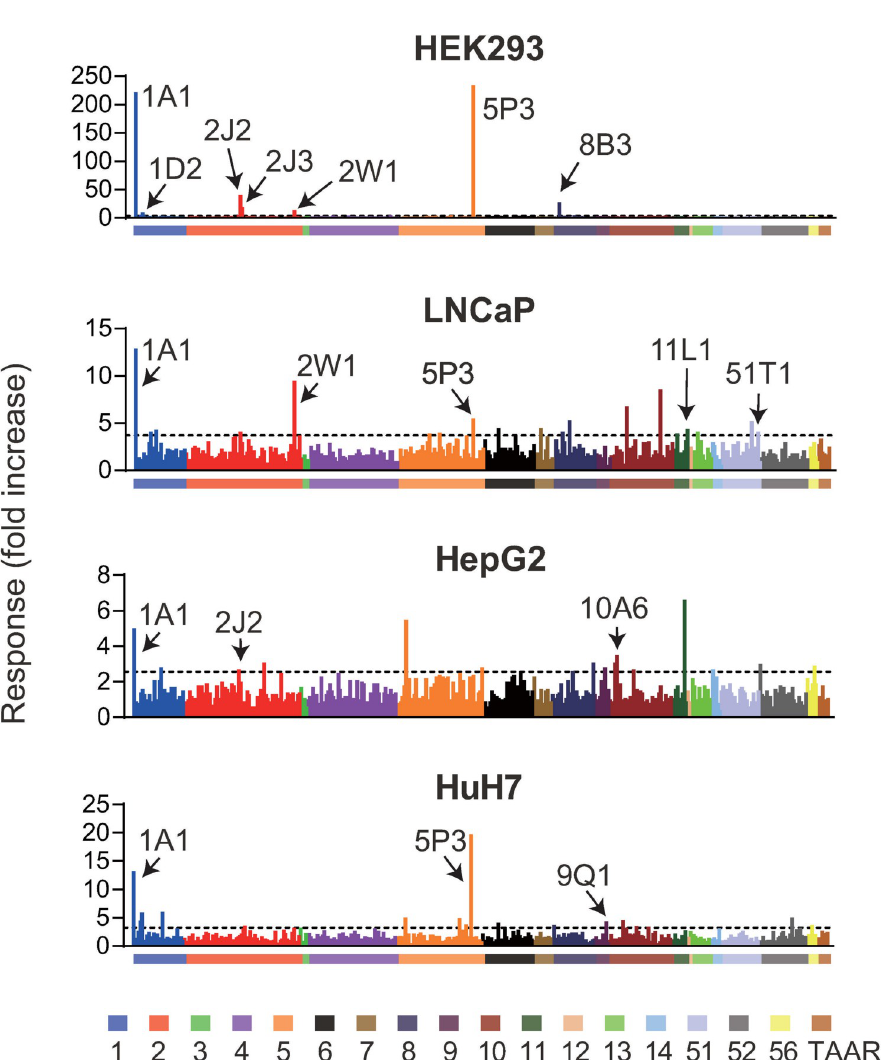
Fig 2. Capacity of three cell lines as a functional expression cell system for ORs. A total of 412 ORs were expressed in different cell lines. Each OR was co-transfected with CRE/luc2PpGL4.29, pRL-CMV, and RTP1S in HEK293 cells whereas G α olf was also co-transfected in the other three cell lines. They were stimulated with a mixture of six odorants in the growth medium without FBS. The X-axis lists each of the 412 ORs, and color bars represent OR families. Y-axis indicates the response of cells expressing each OR as a fold increase. Data are presented as the mean values from two screening replicates. The dashed line denotes mean + 2SD of all the examined ORs except for those validated in HEK293 cells. The name of the receptor is described if the response value in the follow-up dose-response analysis meets our criteria (S3–S6